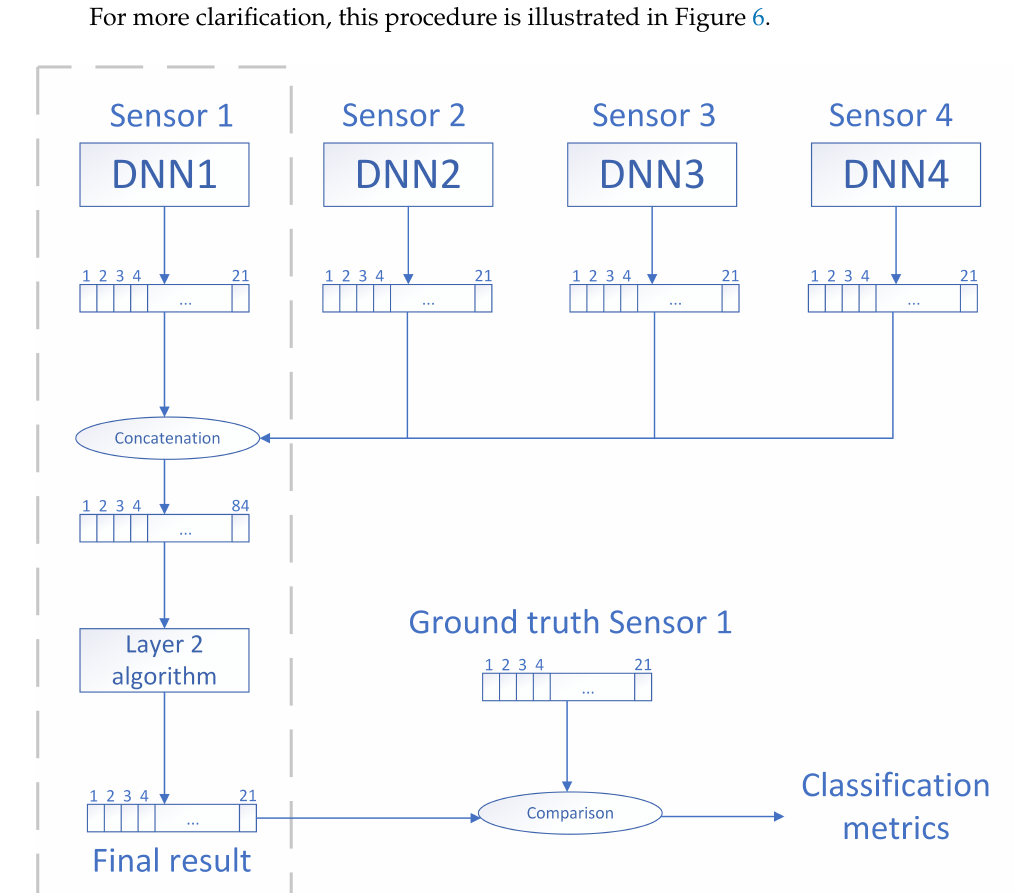
Figure 6. Proposed system architecture with two classification stages. The first deep neural network of the first level outputs a 21-component vector that is later concatenated with the vectors from neighboring nodes. The resulting 84-component vector is examined by the second classification stage to obtain the final classification result. This scheme is replicated on each of the sensors of the